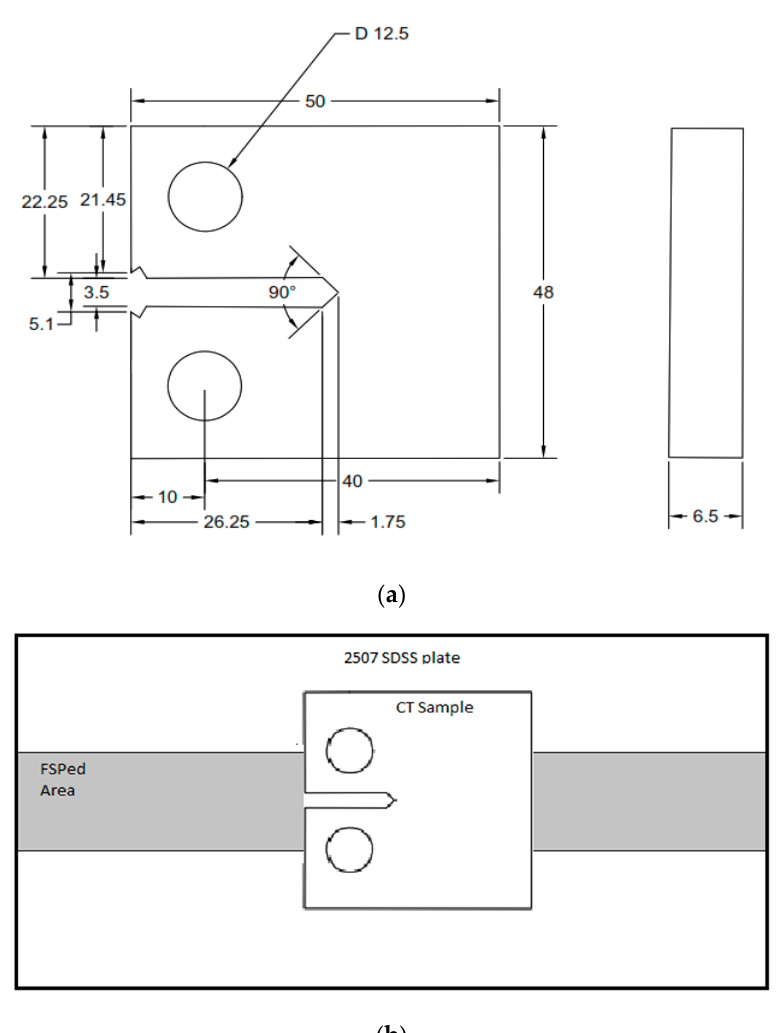
Figure 6. Compact tension (C(T)) sample: ( a ) geometry and dimensions in mm, ( b ) location in processed area.